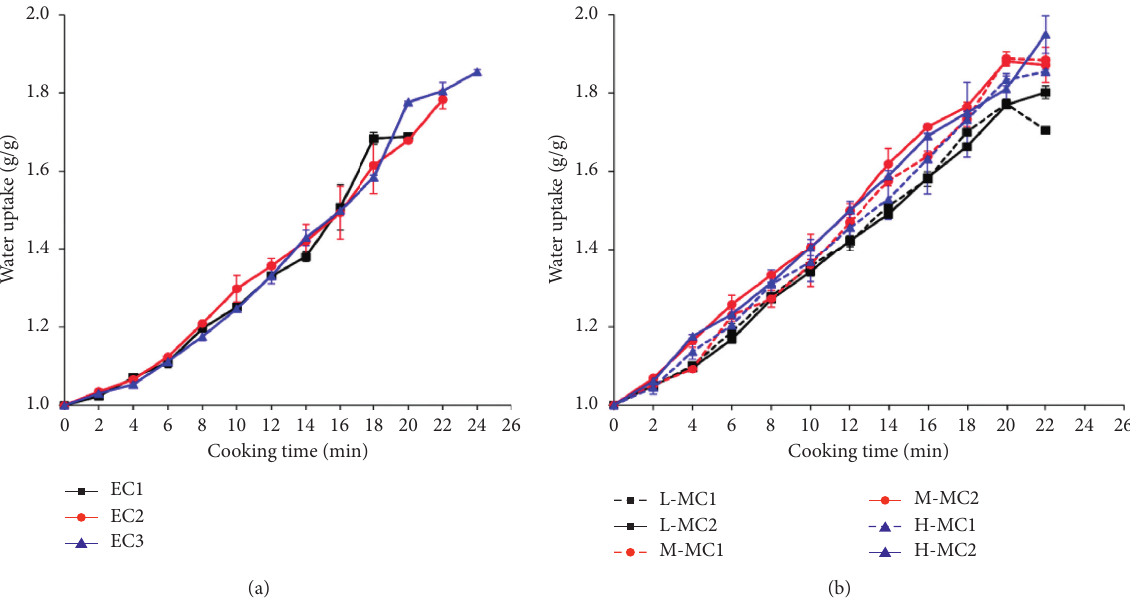
Figure 2: Water uptake during conventional cooking (a) and microwave cooking (b). EC: conventional cooking using an electric rice cooker, L-MC: microwave cooking using low power level, M-MC: microwave cooking using medium power level, and H-MC: microwave cooking using high power level. 1: low water ratio, 2: medium water ratio, and 3: high water